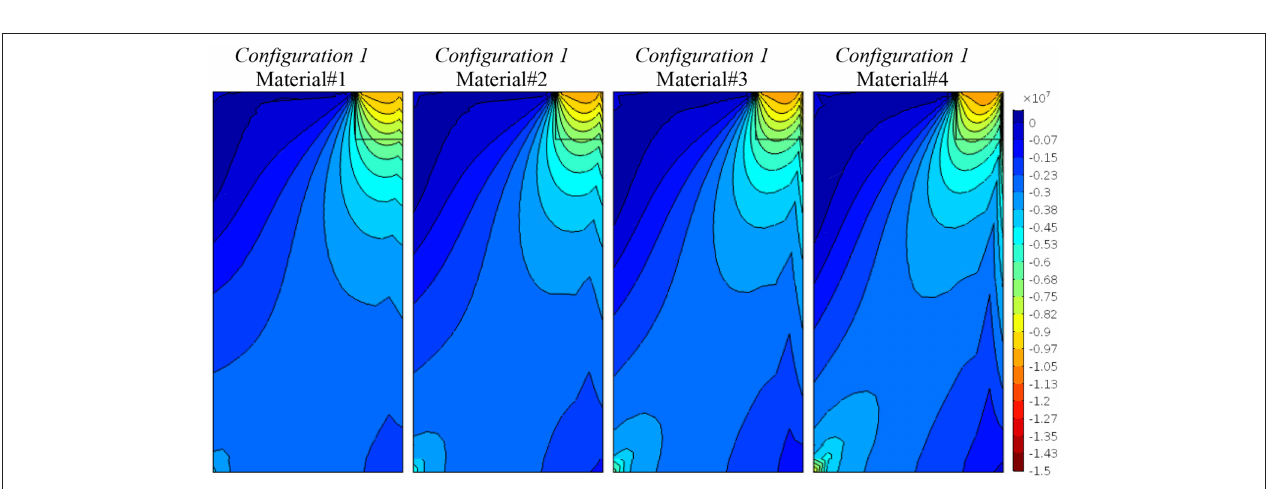
FIGURE 2 | Configuration 1, vertical displacement component, u 2 , contour plots for four material cases (Material#1/Material#4 minimum/maximum anisotropy degree).